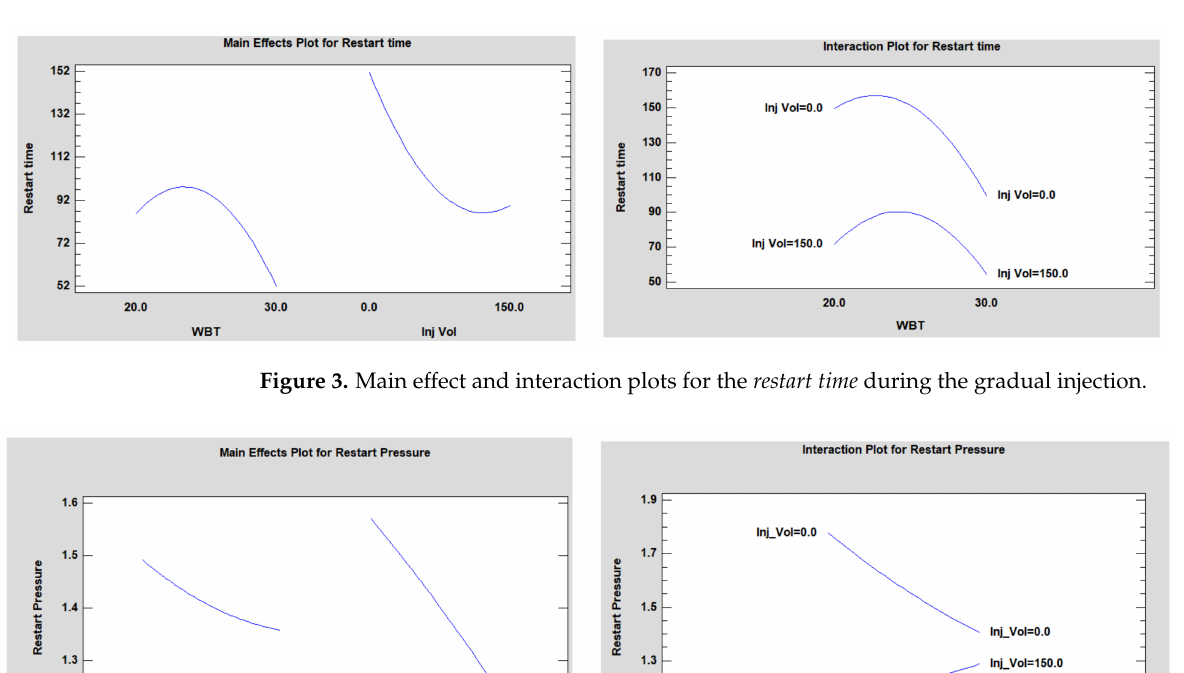
Figure 2. Main effect and interaction plots for the restart pressure during the gradual injection.